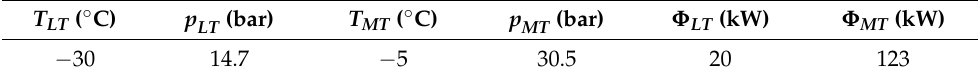
Table 2. Referent supermarket refrigeration system data.